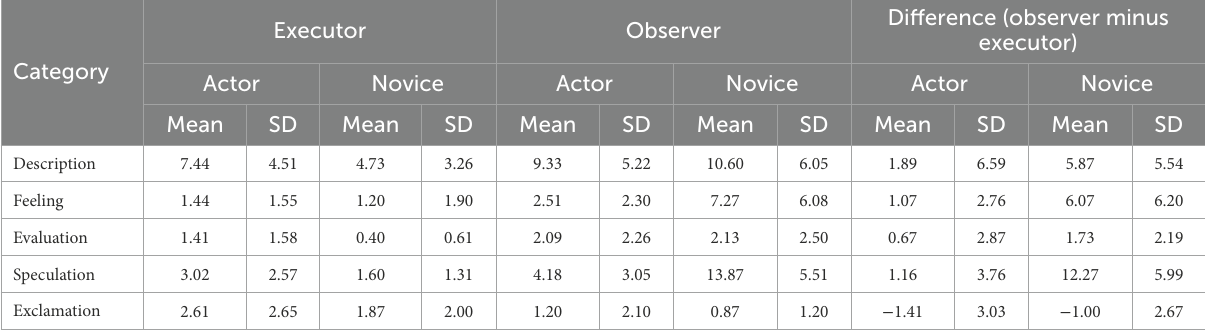
TABLE 4 Descriptive statistics for each kind of utterance in each session for novice actors ( Card or Puzzle session) and professional actors ( Activity session).